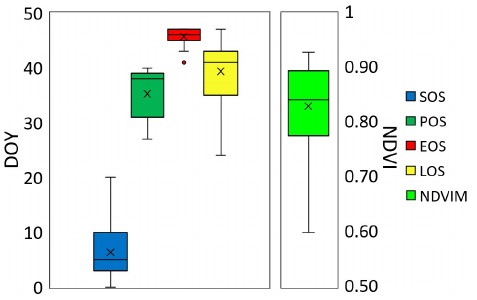
Figure 4 . Boxplots of PMs. Bottom-up: 5 th , 25 th , 50 th , 75 th and 95 th percentiles. Cross is the PM mean value. Dots are outliers.